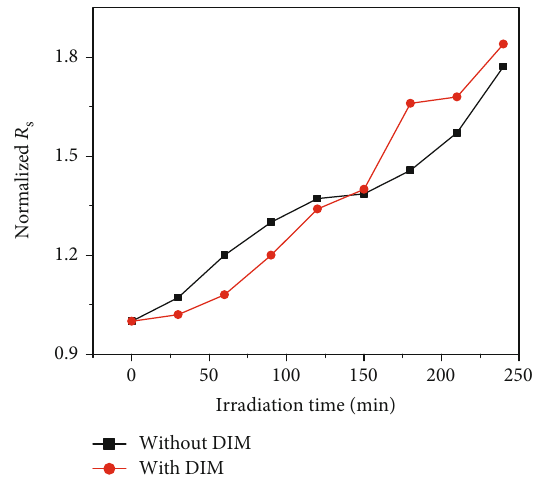
Figure 11: Normalized R s of the PCDTBT:PC 71 BM solar cell processed without and with 3% DIM as a function of irradiation time at ambient air.